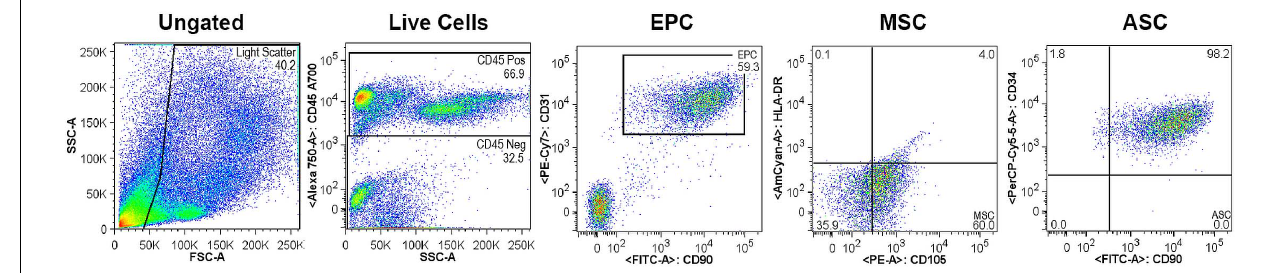
FIGURE 2 | Flow cytometry analyses of cell subpopulations in cryopreserved microfat.